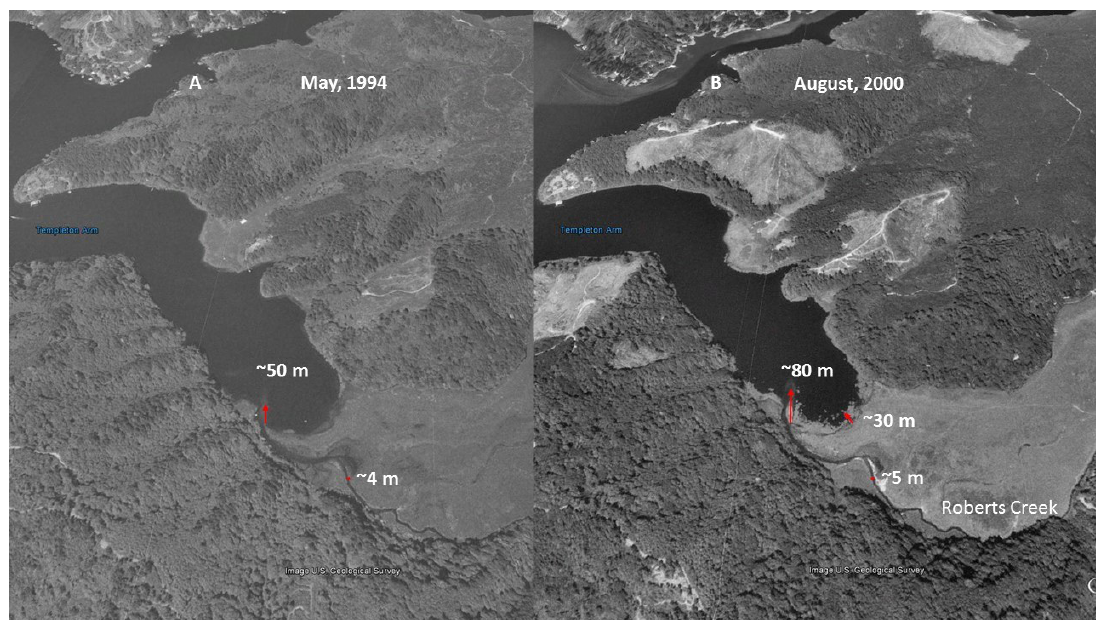
Figure 8. US Geological Survey aerial images of Tenmile Lake, Templeton Arm, and Roberts Creek. ( A ): The May 1994, black and white aerial image shows the Roberts Creek channel is incised, and the delta is expanding. ( B ): The August 2000, black and white aerial image shows the Roberts Creek channel has expanded (Note: the white area indicates stream bank slumping), and the delta has extended into the lake approximately 30 m farther than the May 1994 image. It also shows increased clear cuts on the slopes in three areas north of (above) the lake. Source: Images obtained from Google Earth. Note: Red arrows show the extent of delta growth.